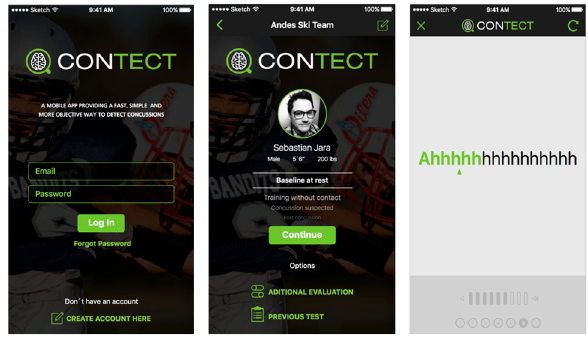
Figure 2. Contect Screenshots.